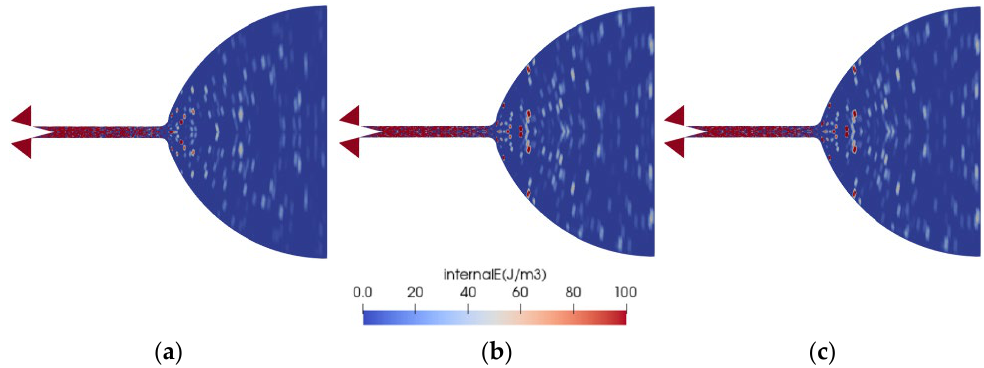
Figure 17. Molecular internal energy distributions in nozzle at different gas temperatures at t = 0.1 ms. ( a ) 285.82 K. ( b ) 293.15 K. ( c ) 300.48 K.